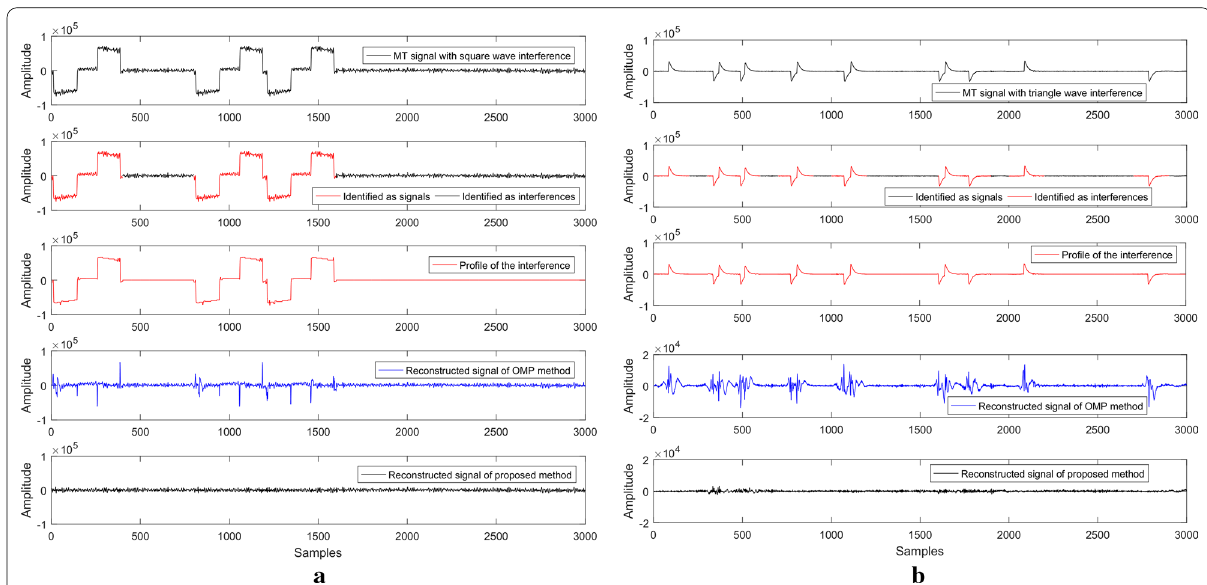
Fig. 5 Signal–noise identification and targeted denoising for the measured MT data. a Square wave interference and b triangle wave interference